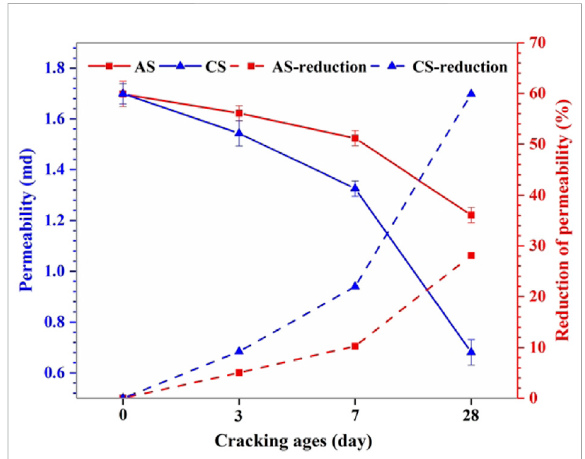
FIGURE 7 Results of the permeability test after self-healing of cement- based material.